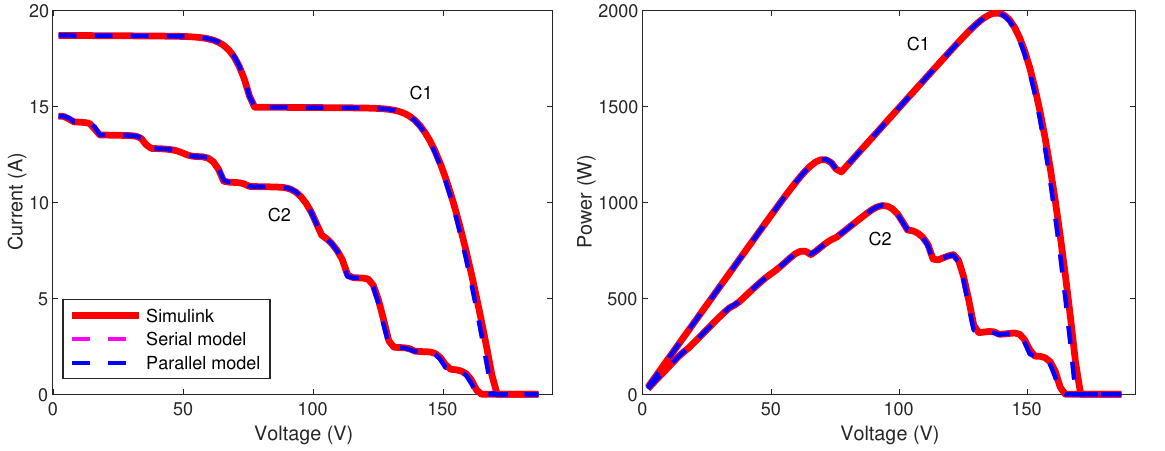
Figure 4. I-V ( left ) and P-V ( right ) curves of a 15 × 2 array under two different partial shading conditions.